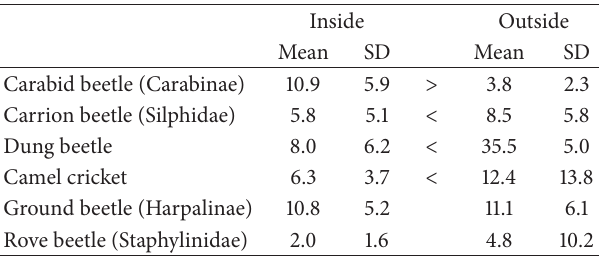
Table 4: Numbers of insects (/100TN; trap night) collected by pit- fall traps inside and outside the deer exclosure at Okutama, western Tokyo,